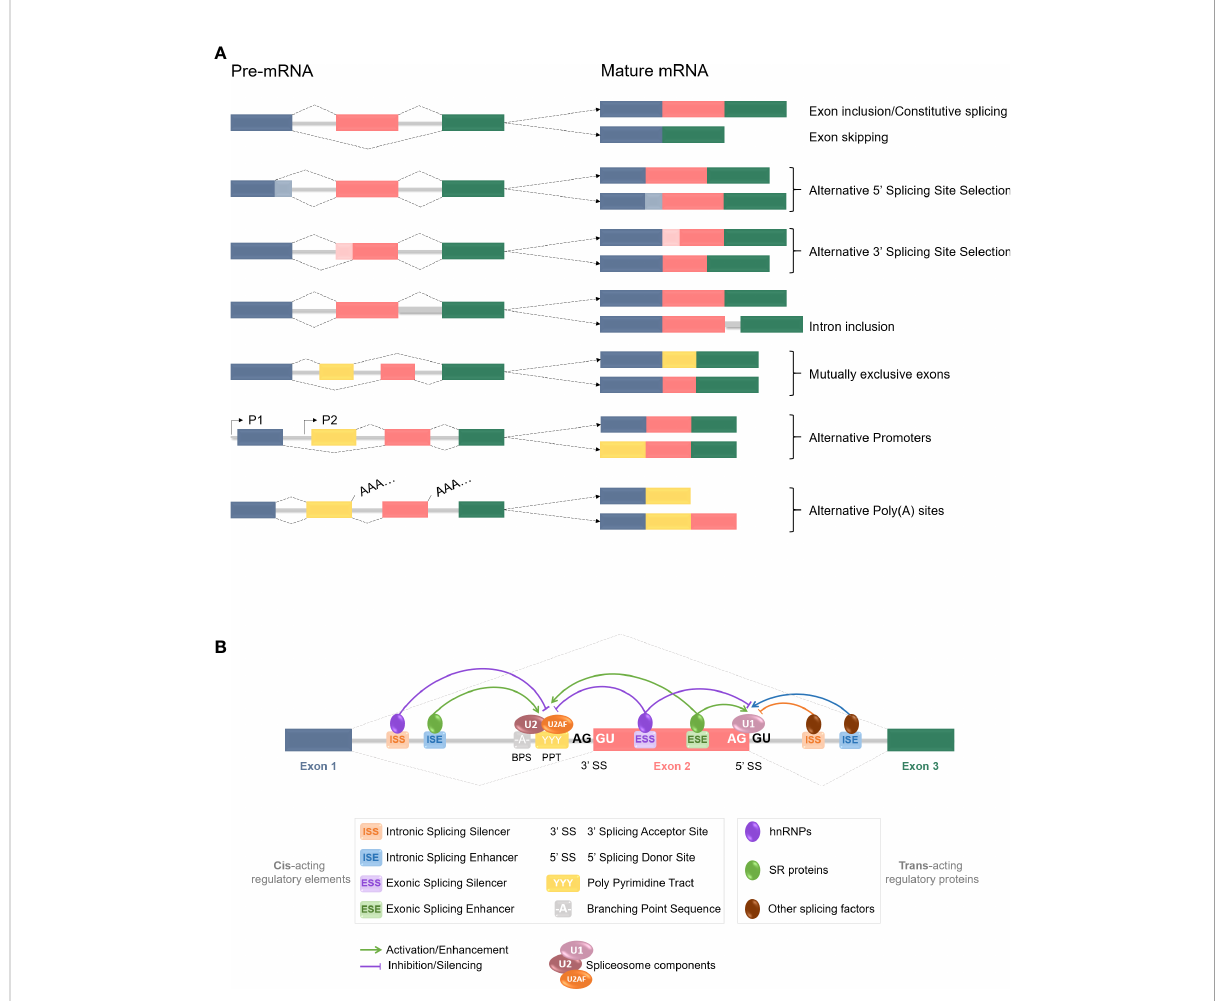
FIGURE 3 pre-mRNA alternative splicing events and regulation mechanisms. (A) Common constitutive and alternative splicing events are listed here. Colored boxes represent different exons, grey lines stand for introns, and dotted lines are splicing events. Exons are usually included or excluded (skipped) individually, but mutually exclusive exons involve the preferential retention of one exon at the expense of one or more others. Alternative 5 ’ and 3 ’ SS selection induce exons modi fi cations, as parts of the exons can be excluded during the process. Introns are mostly removed from the mRNA but inclusion can occur and often leads to nonsense-mediated decay or shift in the Open Reading Frame (ORF). Alternative promoters and poly (A) sites selection can also happen at the splicing level. All those events contribute to the increase of the proteome diversity. (B) Alternative splicing is regulated by trans-acting regulatory proteins, named splicing factors (SFs), binding to cis-acting regulatory sequences. SFs such as SR proteins and hnRNPs are RNA-binding proteins and are considered as enhancers and silencers respectively, since SR proteins are typically recruited to ISEs and ESEs while hnRNPs usually bind to ISSs and ESSs. However, increasing number of studies have revealed more context-dependent regulation roles for each. Other SFs are also at stake, and it is the balance and interplay between those splicing activators and repressors, and with the spliceosome components, that determines the splicing donor and acceptor sites selection for a splicing event to